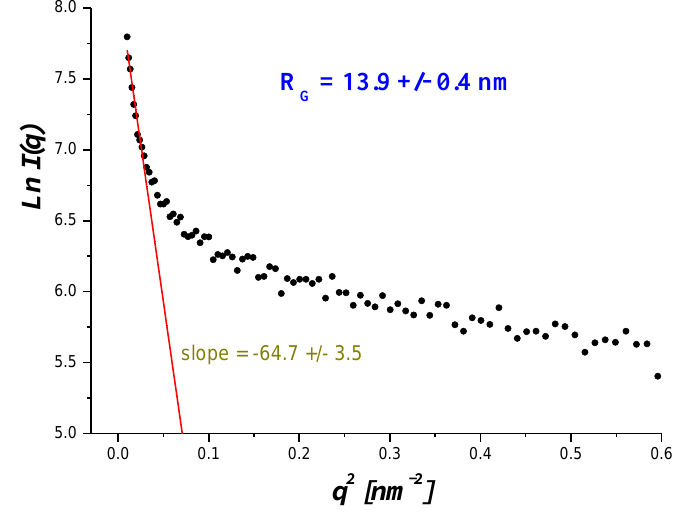
Figure 5. The Guinier plot for the Bu sample.